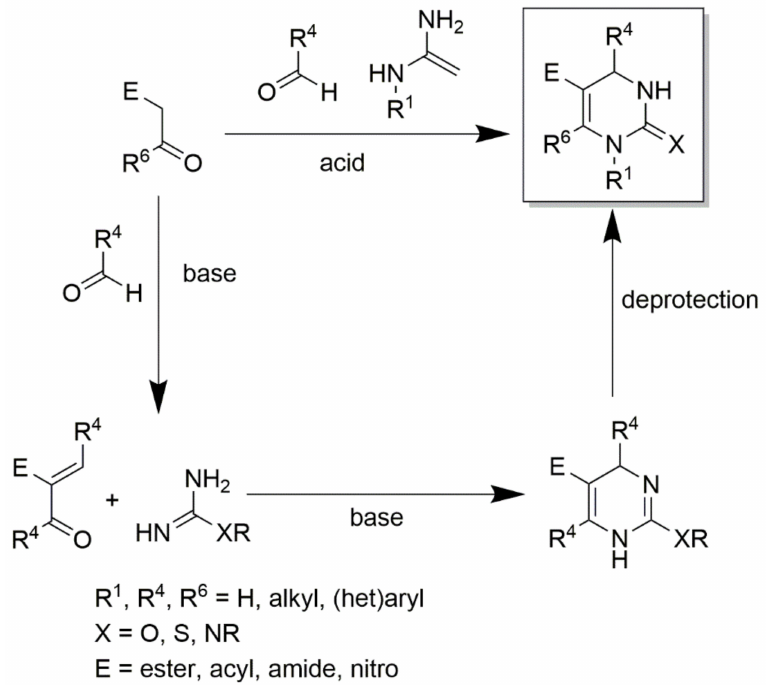
Scheme 9. An illustration of obtaining protected DHPMs using protected urea or thioureas or guanidines under weak basic conditions with the aldehyde and CH-acidic carbonyl components.